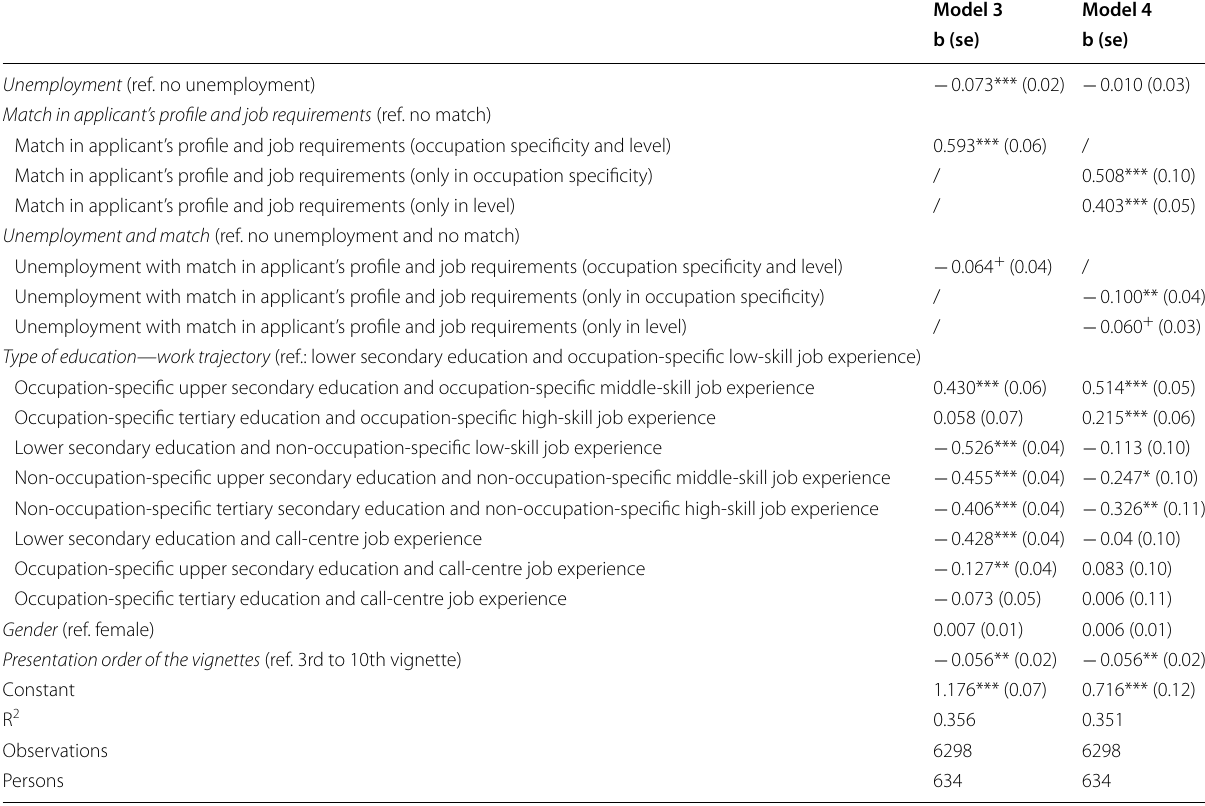
Table 4 Scarring effects of unemployment with profile match as moderator (standard errors are displayed in parenthe-